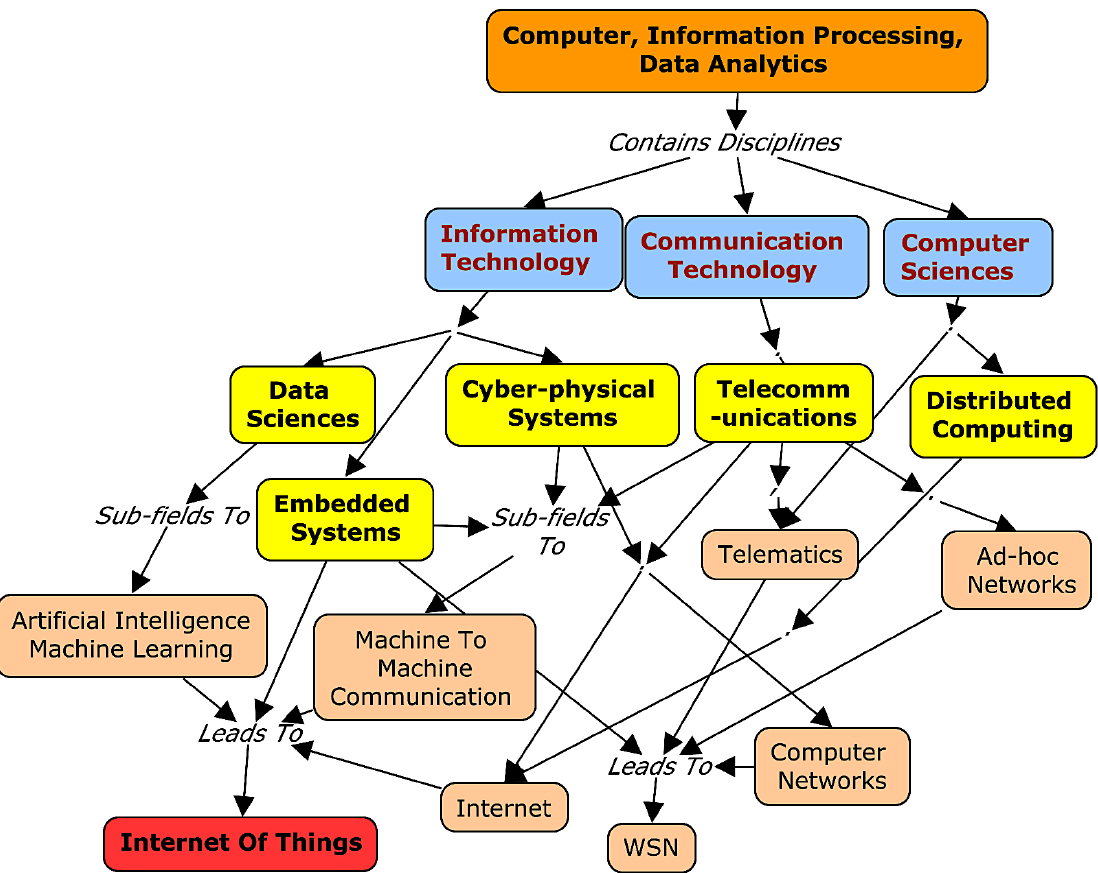
Figure 3. Etymological relationship/differences between IoT and WSN.